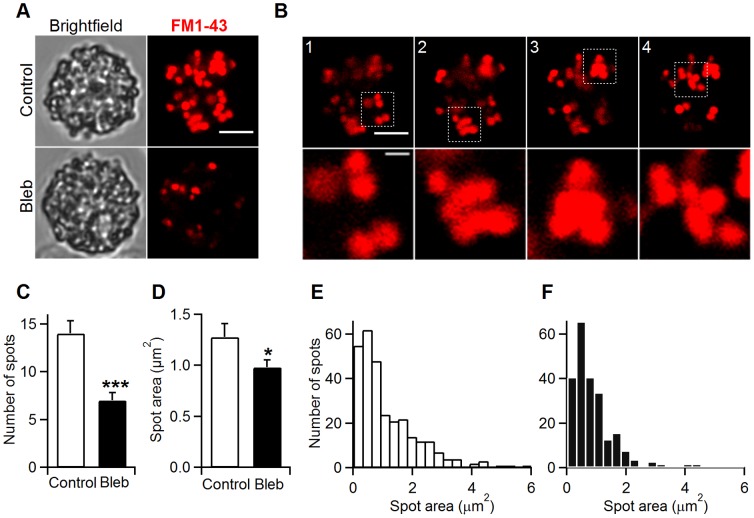
Compound endocytosis is inhibited by blebbistatin.The left images show brightfield single confocal sections, while the right images show Z-stack projections of endocytic spots labelled with FM1-43 (A). The data are from control cells (Control) and cells treated with blebbistatin (Bleb) (5 µM). In panel B, the upper pictures (1–4) show a sequence obtained gradually (at 2 µm separation) from the control cell shown in A. The lower pictures show an enlarged view of groups of endocytic vesicles (enclosed by a box in images 1–4) (B). A bar graph shows that the number of FM1-43 spots per cell in control (white) and blebbistatin conditions (black) was significantly different (C). The area of FM1-43 spots per cell was significantly reduced by blebbistatin (black) compared to control cells (white) (D). Histograms of the spot area for control conditions (E, white) and blebbistatin treatment (F, black). Scale bars: 5 and 1 (insets) µm. Error bars, S.E.M. *p<0.05; ***p<0.001.